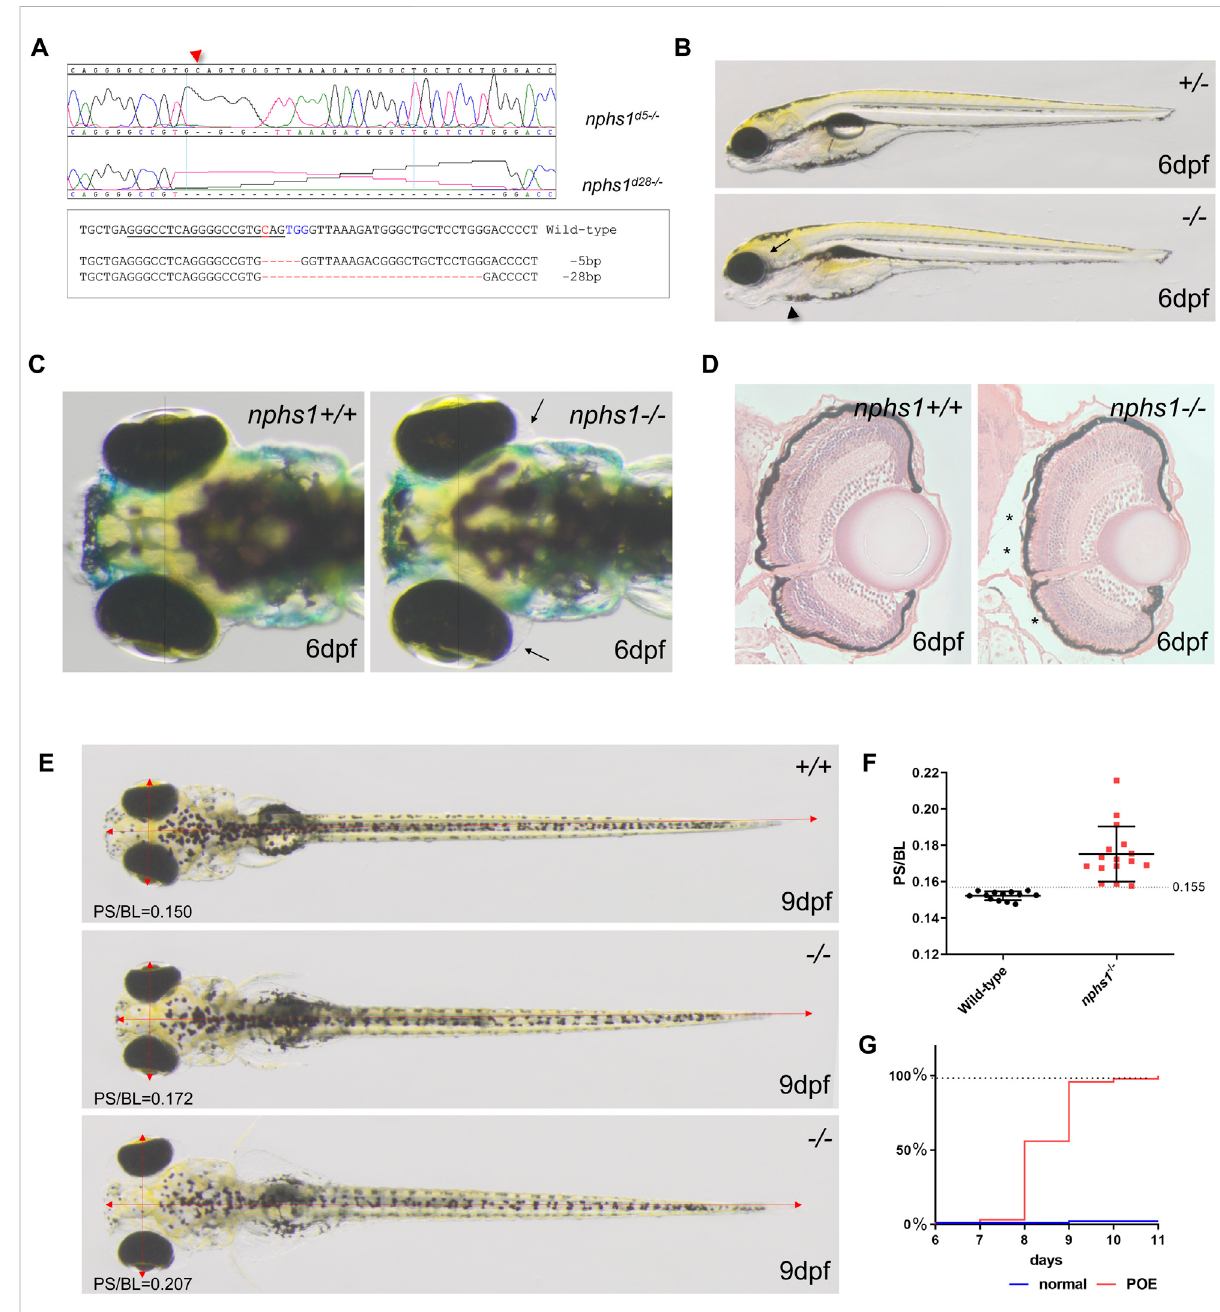
Generationofnphs1mutantzebra fi shbyCRISPR/Cas9-mediatedgeneediting. (A) Sangersequencingofthetwodifferentnphs1mutantalleles. Sequence alignment of two nphs1 mutant alleles compared to the wild-type nphs1 gene sequence. PAMs are shown in blue color and sgRNA target sequence is underlined. The DNA break site by Cas9 is indicated red. (B) Morphological phenotype of nphs1 mutant at 6 dpf. The nphs1 mutant exhibited peri-orbital edema (arrow) and mild pericardial edema (arrowhead). (C) Dorsal view of the head region of zebra fi sh larvae. The nphs1 mutants exhibit peri-orbital edema (arrows) compared to wild-type siblings at 6 dpf. (D) Cross sections of periorbital region in wild-type and nphs1 mutants at 6 dpf. H&E staining shows the severity of peri-orbital edema (asterisks). (E) nphs1-/- develops severe periorbital and whole-body edemaat9dpfcomparedto wild-type siblings. Red arrows indicate thepupilspacing distance (PS)and thebody length (BL). (F) Scatter plotshowing measurement of PS/BL in nphs1 mutants at 9 dpf. Each data point represents an individual larva and lines indicate the mean values. The error bars show the standard error of the mean (SEM). (G) Progression of the peri-orbital edema in nphs1 mutants (red line) and wild-type controls at 6 – 11